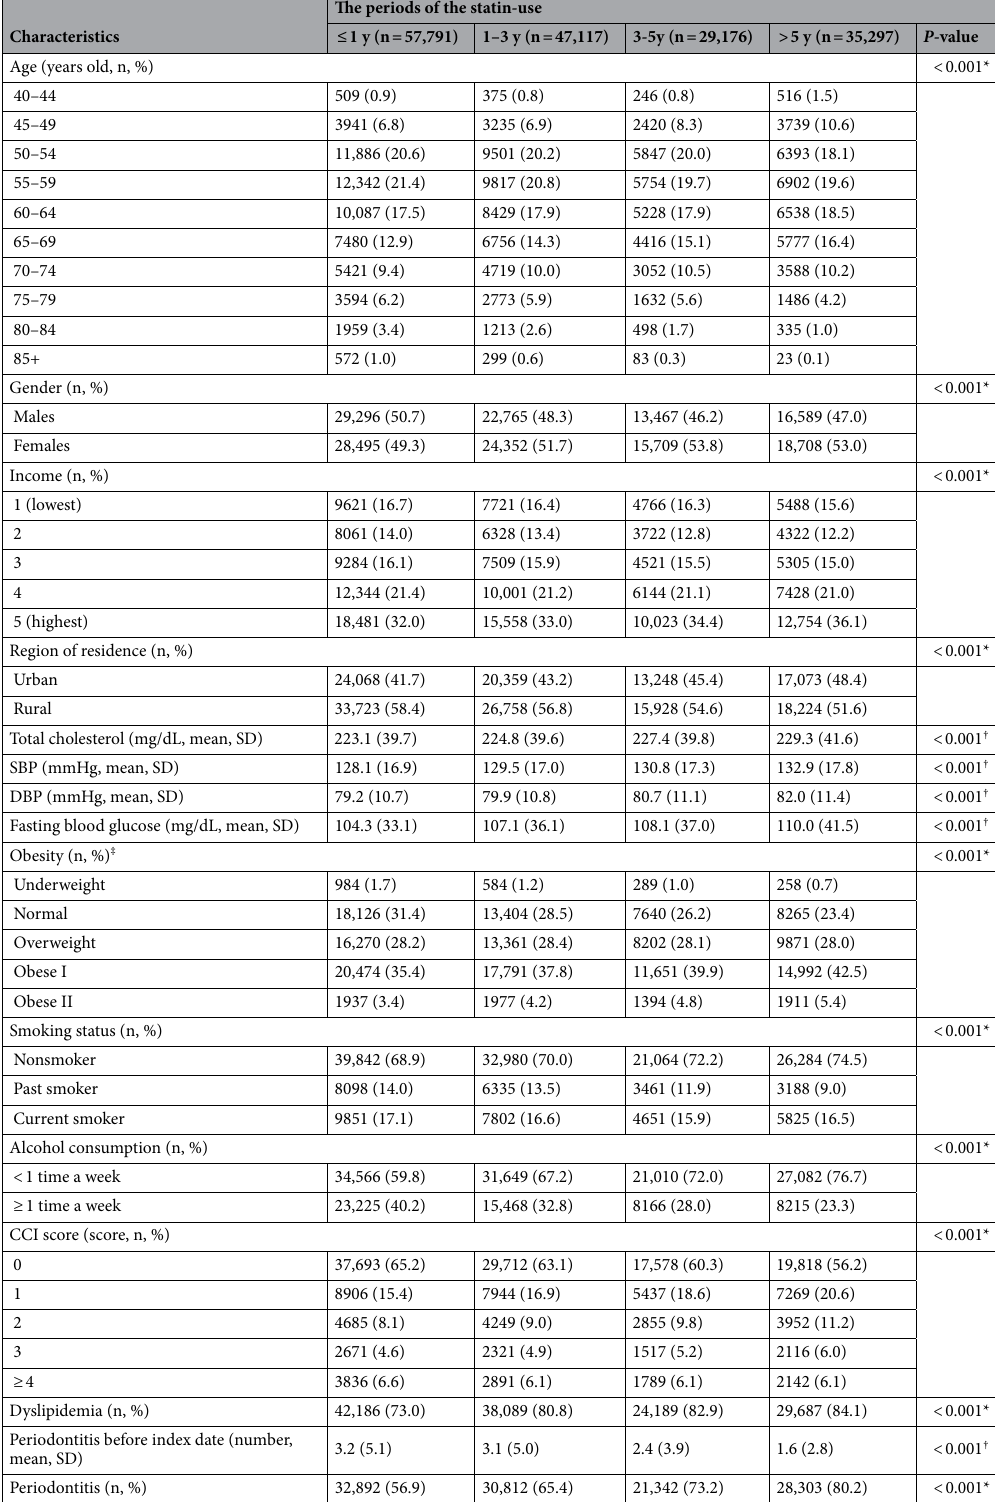
Table 2. General characteristics of participants in statin user according to the periods of the statin-use. SBP systolic blood pressure, DBP diastolic blood pressure, CCI Charlson comorbidity index, SD standard deviation. *Chi-square test. Significance at P < 0.05. † One-way analysis of variance (ANOVA). Significance at P < 0.05. ‡ Obesity (BMI, body mass index, kg/m 2 ) was categorized as < 18.5 (underweight), ≥ 18.5 to < 23 (normal), ≥ 23 to < 25 (overweight), ≥ 25 to < 30 (obese I), and ≥ 30 (obese